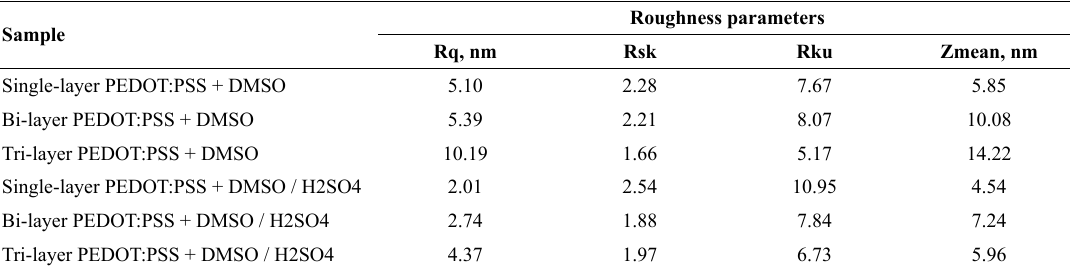
Figure 1. Characteristic AFM topographical images of (a, b, c) untreated and (a1, b1, c1) sulfuric acid treated PEDOT:PSS+DMSO (a, a1) single-layer, (b, b1) bi-layer, and (c, c1) tri-layer Table 1. Summary of the roughness parameters for untreated and sulfuric acid treated PEDOT:PSS+DMSO films